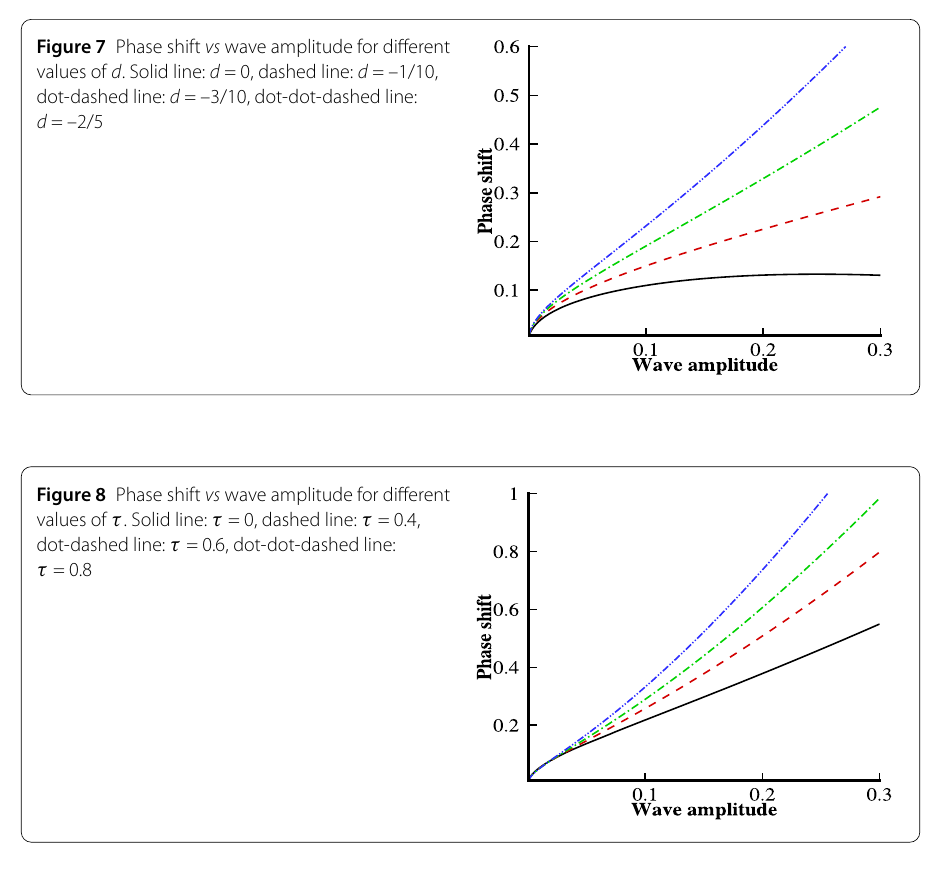
Figure 7 Phase shift vs wave amplitude for different values of d . Solid line: d = 0, dashed line: d = –1/10, dot-dashed line: d = –3/10, dot-dot-dashed line: d = –2/5